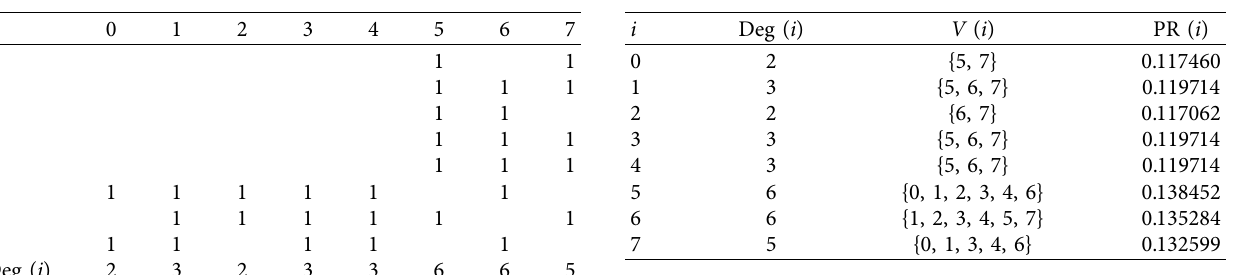
A LGORITHM 1: PageRank algorithm. Table 3: The adjacency matrix.